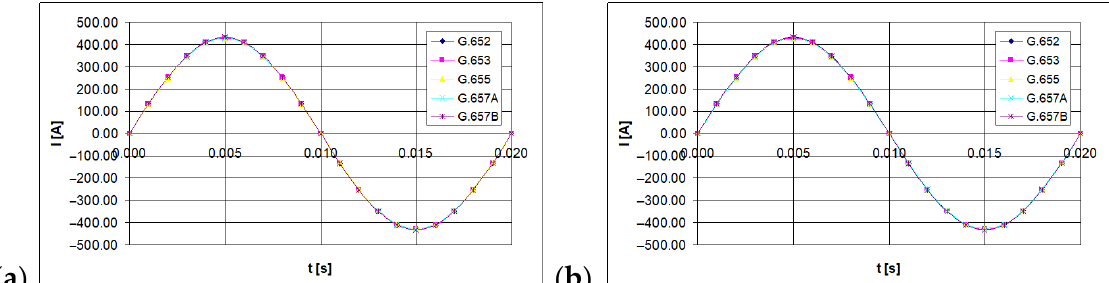
Figure 4. The time waveform measured with forced RMS current value of 300 A, depending on the single mode telecommu- nications fiber standard [own results]: ( a ) for 40-turns measuring coil and ( b ) for 80-turns measuring coil.